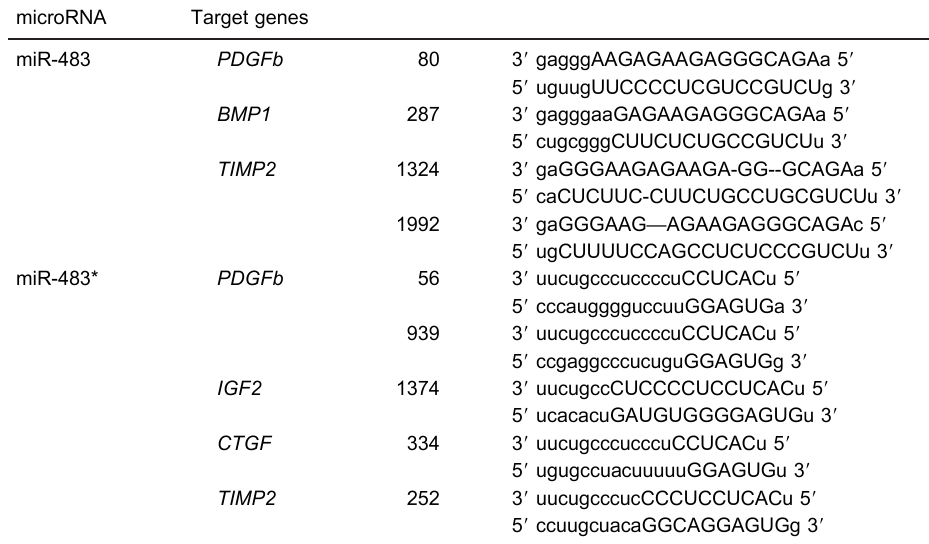
Table 4. Target genes of miR-483 and